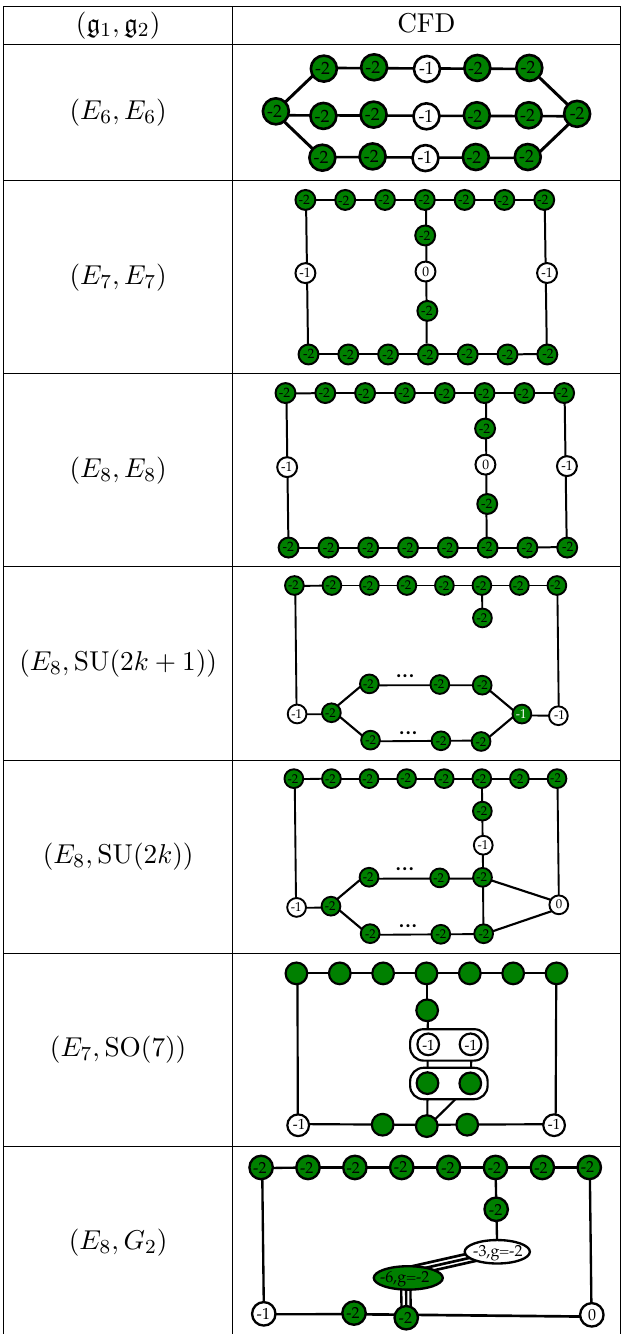
Table 12. CFDs for minimal conformal matter building